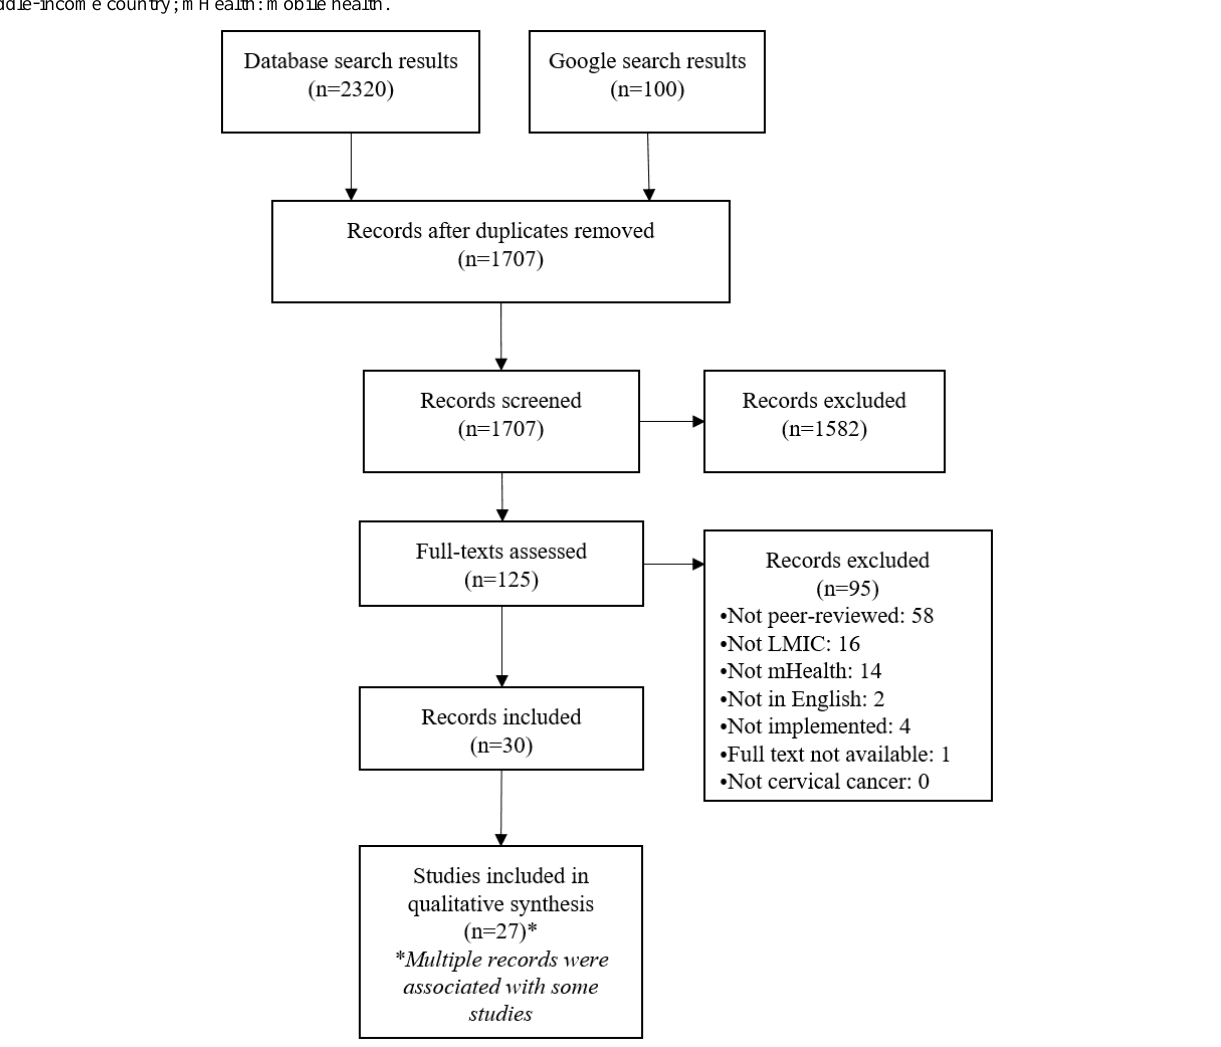
Figure 1. PRISMA (Preferred Reporting Items for Systematic Reviews and Meta-Analyses) flowchart of systematic search results. LMIC: low- and middle-income country; mHealth: mobile